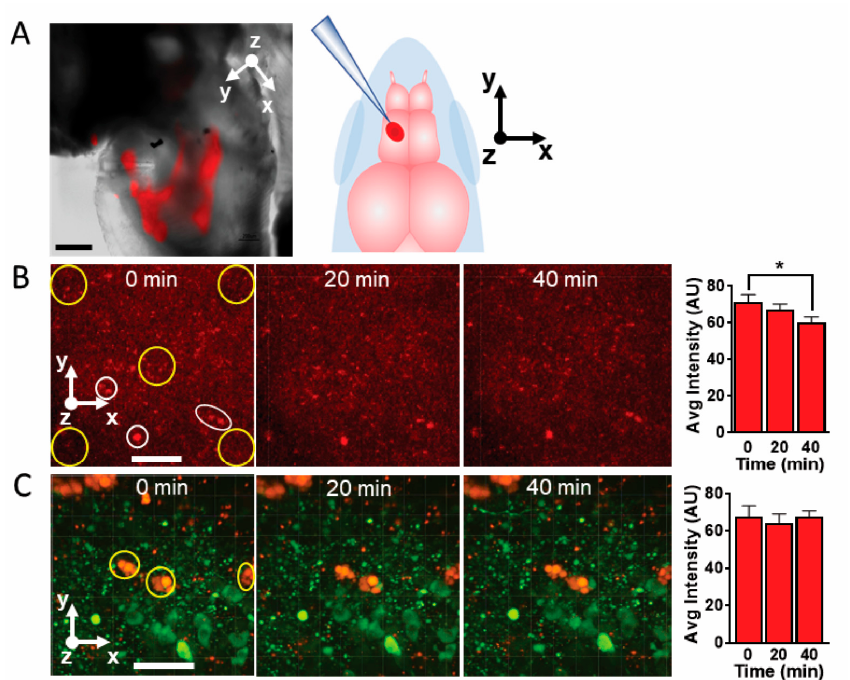
Figure 5. Nanoprobes remain immobile while free DsRed protein molecules tend to diffuse. ( A ), DsRed-AuBP functionalized nanoparticles, 15 nm diameter injected in the ventral diencephalon area of a viable zebrafish brain. Image obtained by overlaying fluorescence on brightfield images. The diagram on the right indicates the approximate location and orientation of spritzing. ( B ), Three- dimensional 2PE image of injected DsRed protein in living zebrafish brain. Sampled regions (yellow circles) and reference points (white circles and ellipse) are depicted at 0 min. The bar graph on the right indicates the average fluorescence intensity inside the yellow circles. Scale bar = 50 µm. * p = 0.0091 (two-tailed t-test, n = 5 regions sampled per time point). Z -axis slice thickness = 80 µm. Ori- entation: x -axis, caudal; y -axis, lateral; z -axis, ventral. ( C ), DsRed-BP-AuNPs, 15 nm diameter, were picospritzed in live zebrafish brain and imaged with 3D 2PE microscopy. The spatial relationships between the GFP-labeled dopamine neurons (green) and nanoprobes (red) are unchanged. The bar graph on the right indicates the average fluorescence intensities of the regions enclosed in yellow circles and ellipses measured over time. Orientation: x -axis, caudal; y -axis, lateral; z -axis, ventral. 3D images in B and C were captured on a Zeiss Axio Examiner.Z1.